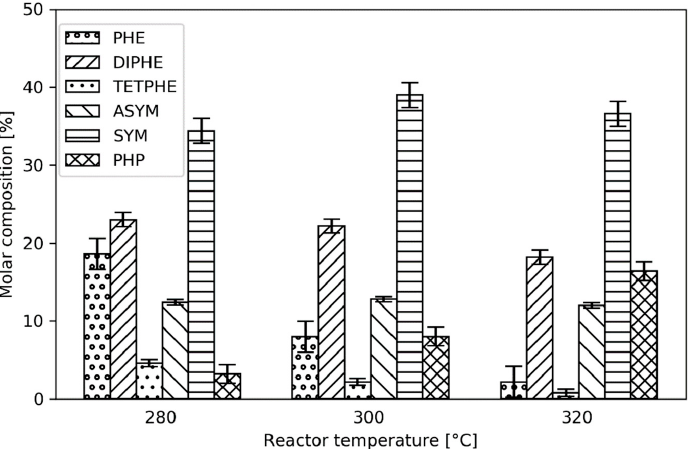
Figure 2. Product distribution from the hydrogenation of phenanthrene at different reactor temperatures.